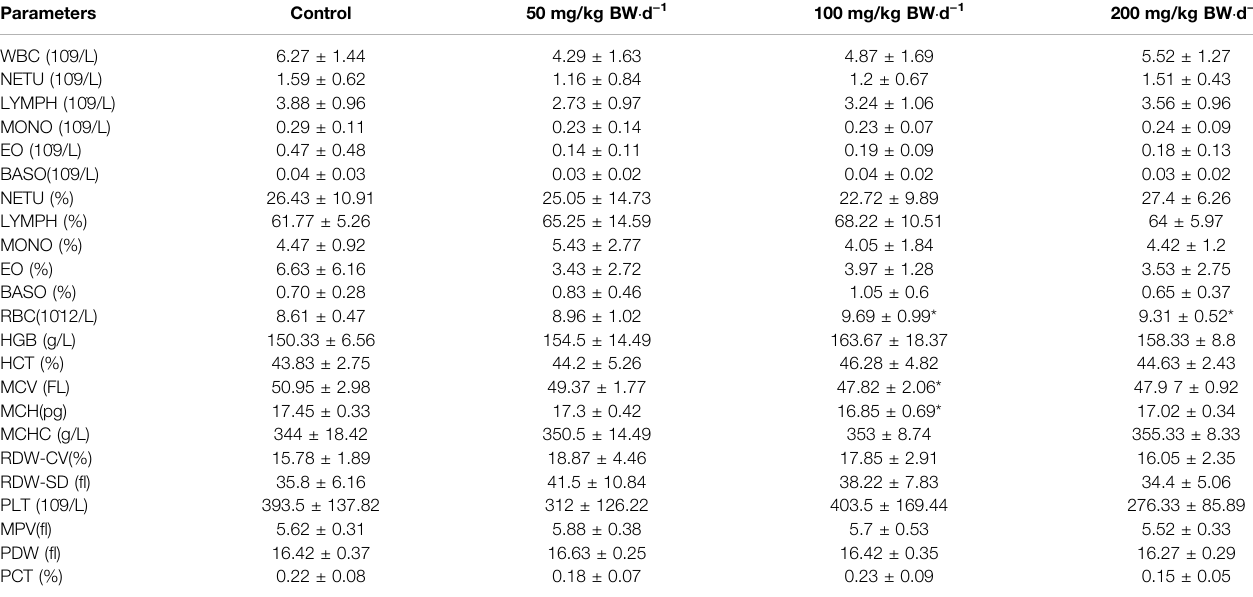
TABLE 2 | Effect of daily oral administration of jaranol on hematological parameters in mice. Parameters